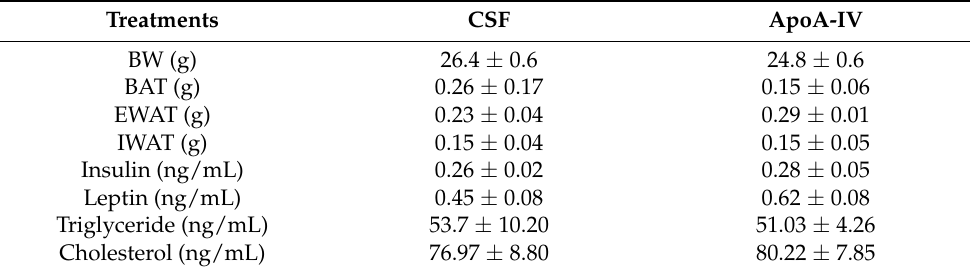
Table 1. Experiment 1: body weight, tissue weight, and levels of plasma parameters. After fasting for five hours, mice (n = 7/group) received intracerebral administration of either CSF (1 µL) or recombinant ApoA-IV protein at 12 µg/µL (1 µL). Plasma and tissues were collected 40 min after injections. Values are presented as the means ± SEM. BW: body weight; BAT: brown adipose tissue; EWAT: epididymal white adipose tissue; IWAT: inguinal white adipose tissue.